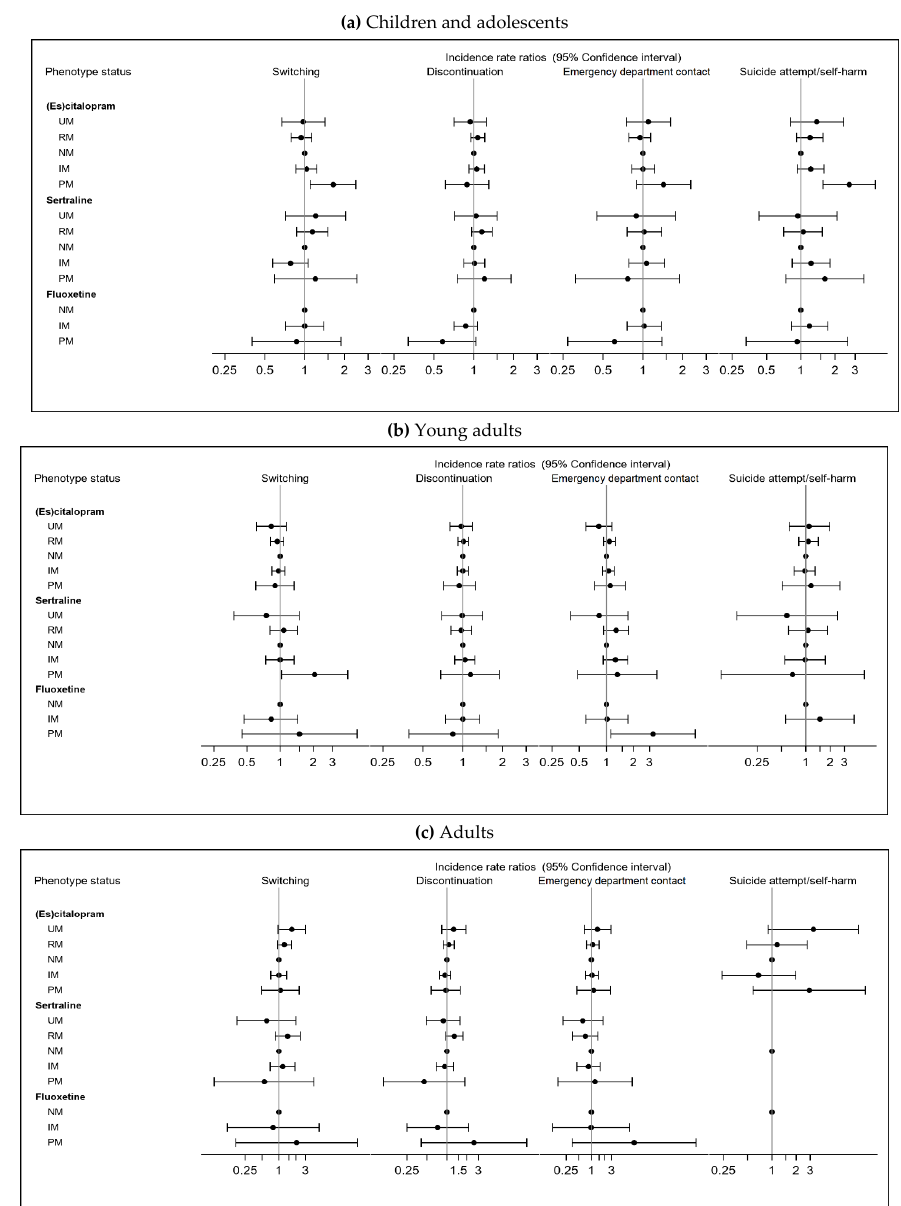
Figure 1. Adjusted incidence rate ratios (IRR) and 95% confidence intervals of the associations between the CYP2C19 and CYP2D6 phenotypes and clinical outcomes in people with a hospital depression diagnosis between 1 January 1996 and 31 December 2012 and a first-time prescription for (es)citalopram, sertraline, or fluoxetine between 1 January 1996 and 31 December 2016, stratified by age groups ( ≤ 18, 19–25, 26+ years). Abbreviations: UM: ultra-rapid metabolizer, RM: rapid metabolizer, NM: normal metabolizer, IM: intermediate metabolizer, PM: poor metabolizer. NM was the reference group. IRR were adjusted for: age, gender, region of index prescription, socio- economic status (SES), number of previous psychiatric diagnosis, CYP2C19/CYP2D6 inhibitor and inducer use within the last three months of index date, and calendar year of index prescription. For emergency department contact, we further adjusted for any hospital contacts within the previous year of index date. For the outcome of suicide attempt/self-harm, we also adjusted for previous suicide attempt/self-harm and for antiepileptic drug use within the last three months of index